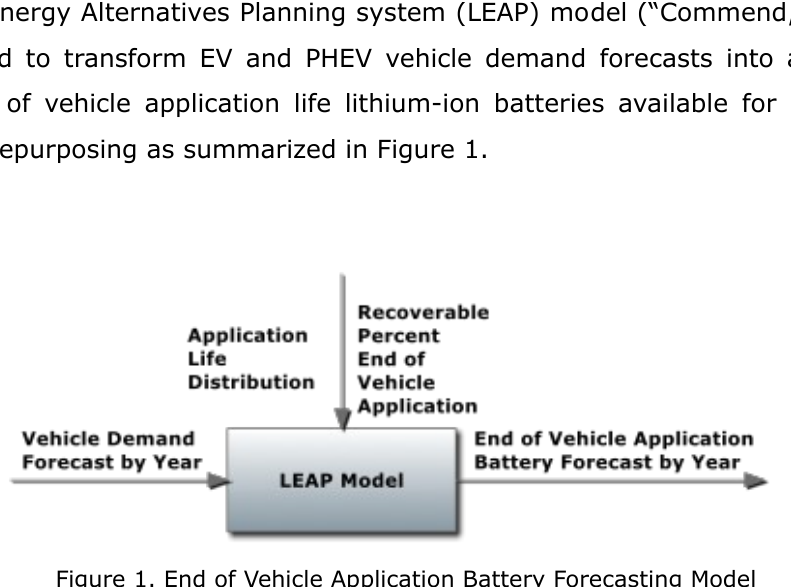
Figure 1. End of Vehicle Application Battery Forecasting